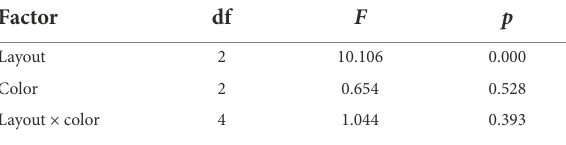
TABLE 9 Results of repeated measures ANOVA on number of fixations.